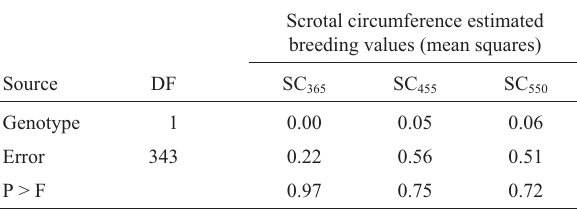
Table 5 - Scrotal circumference (SC, in centimeters) estimated breeding values for the G5501 → T (G, n = 247; T, n = 71) mitochondrial tRNA asn single nucleotide polymorphism (SNP). The table shows the means and standard errors of the mean (SE) for SC estimated breeding values at 365, 450 and 550